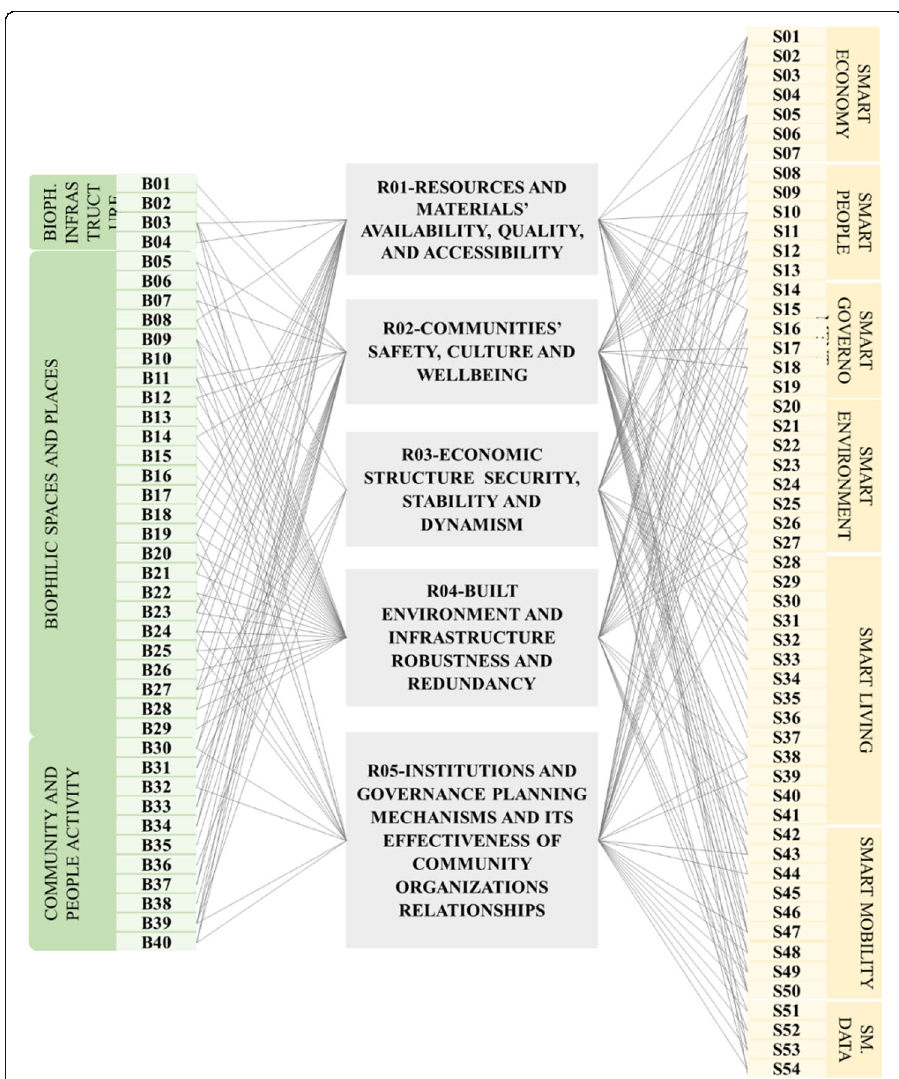
Fig. 6 Cross-relationship between principles of urban resilience and indicators of biophilic and